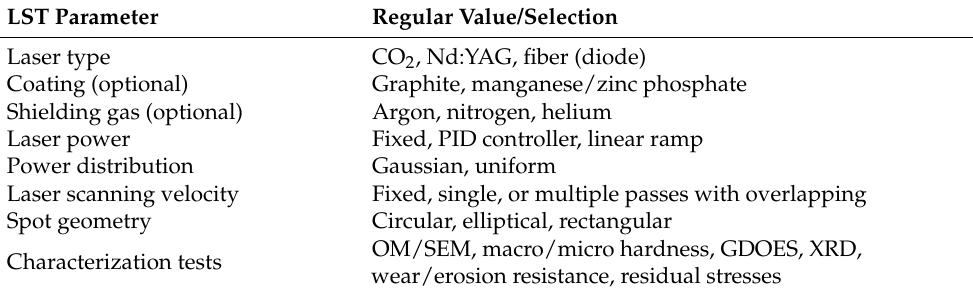
Table 1. Typical parameters and characterization tests used in LST of cast